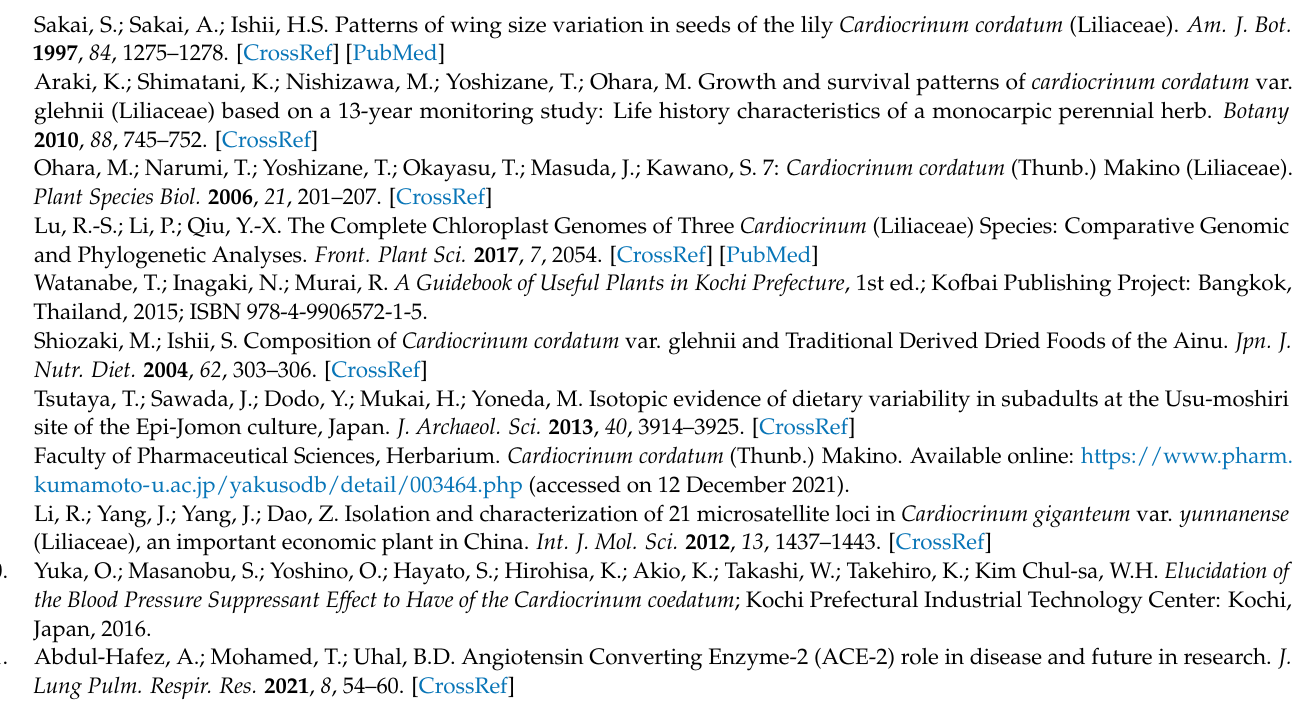
C. cordatum sample collection; Figure S2. Thematic maps of various conditioning factors with plant locations used for predicting habitat suitability of C. cordatum